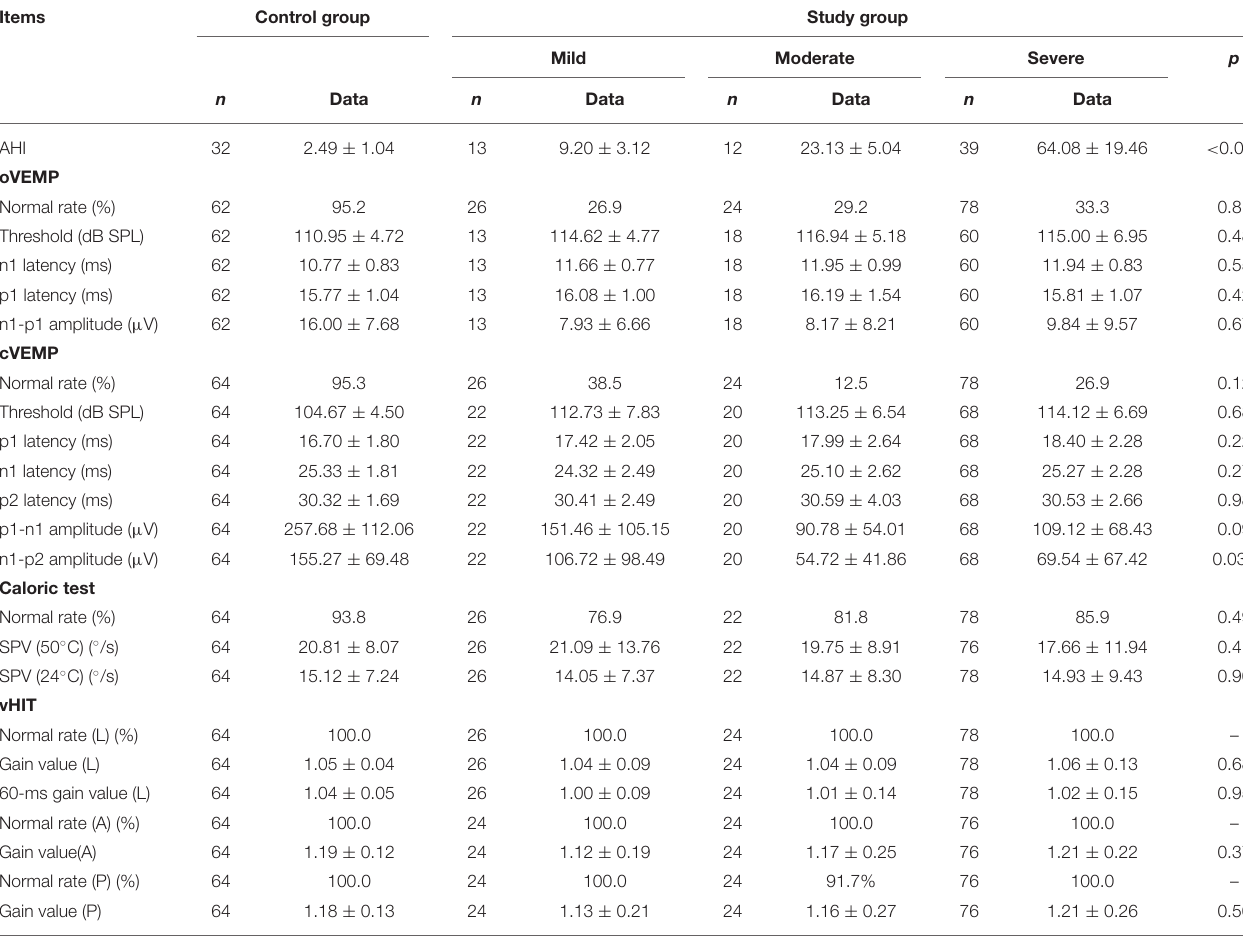
TABLE 3 | The normal rates and parameters of VEMPs, Caloric test, and vHIT in OSA of different severity.